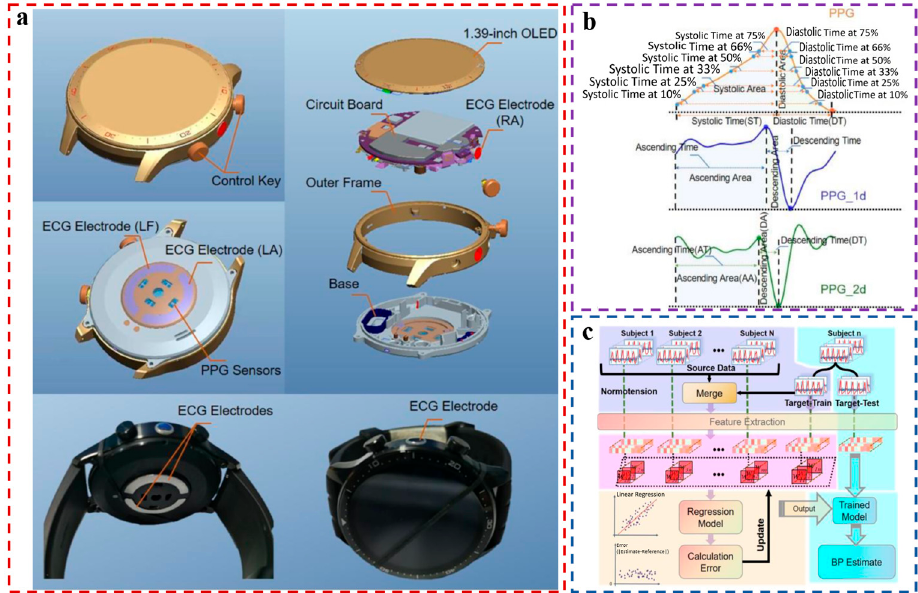
Figure 9. ( a ) Smartwatch that can collect ECG and PPG signals synchronously; ( b ) Time-domain features extracted from a single pulse period; ( c ) Process of the personal calibration mode based on transfer learning. Reproduced with the permission of [8]. Copyright 2022, Elsevier.